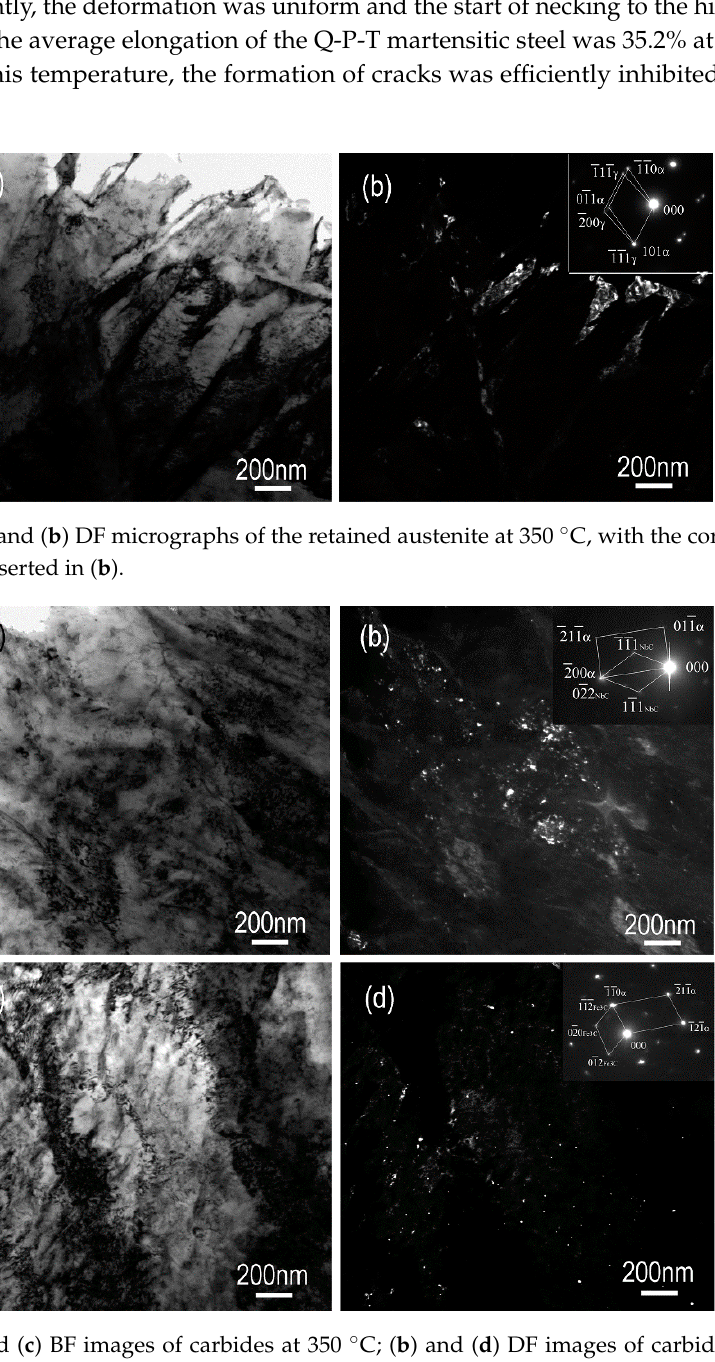
Figure 8. ( a ) and ( c ) BF images of carbides at 350 °C; ( b ) and ( d ) DF images of carbides, with the corresponding SAED pattern of NbC and Fe 3 C inserted in ( b ) and ( d ), respectively.